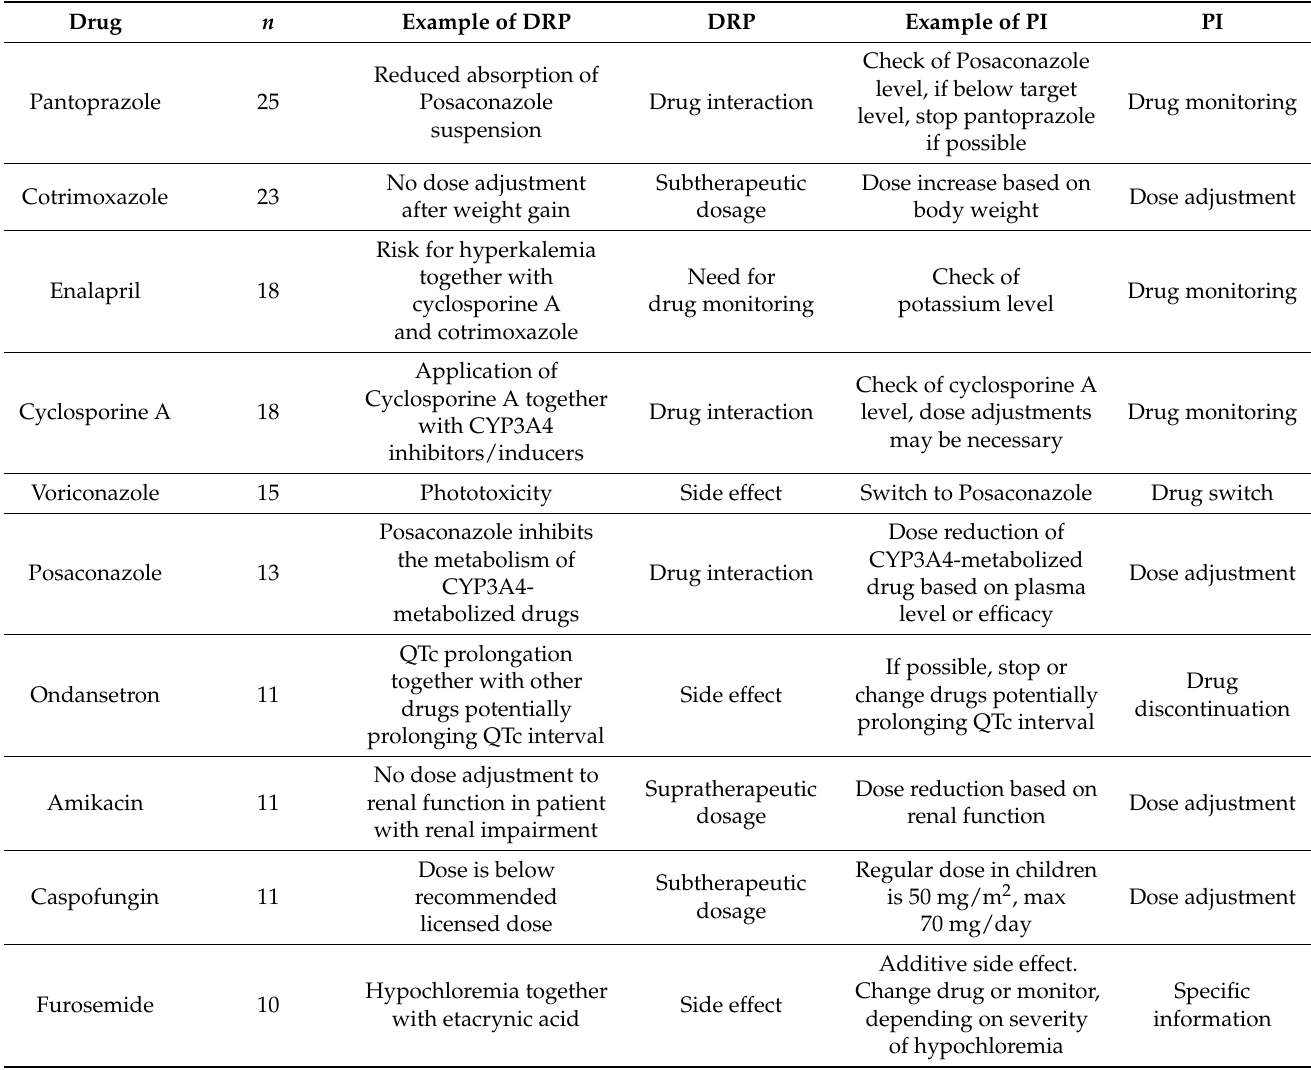
Table 1. Top 10 drugs involved in detected drug-related problems (DRP) and corresponding examples of DRP and pharmaceutical interventions